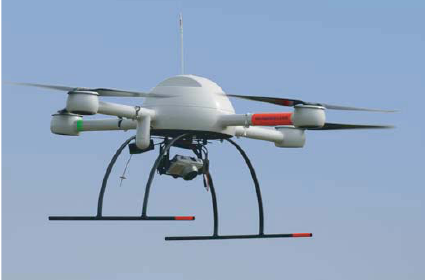
Figure 3. The Microdrone md4-1000